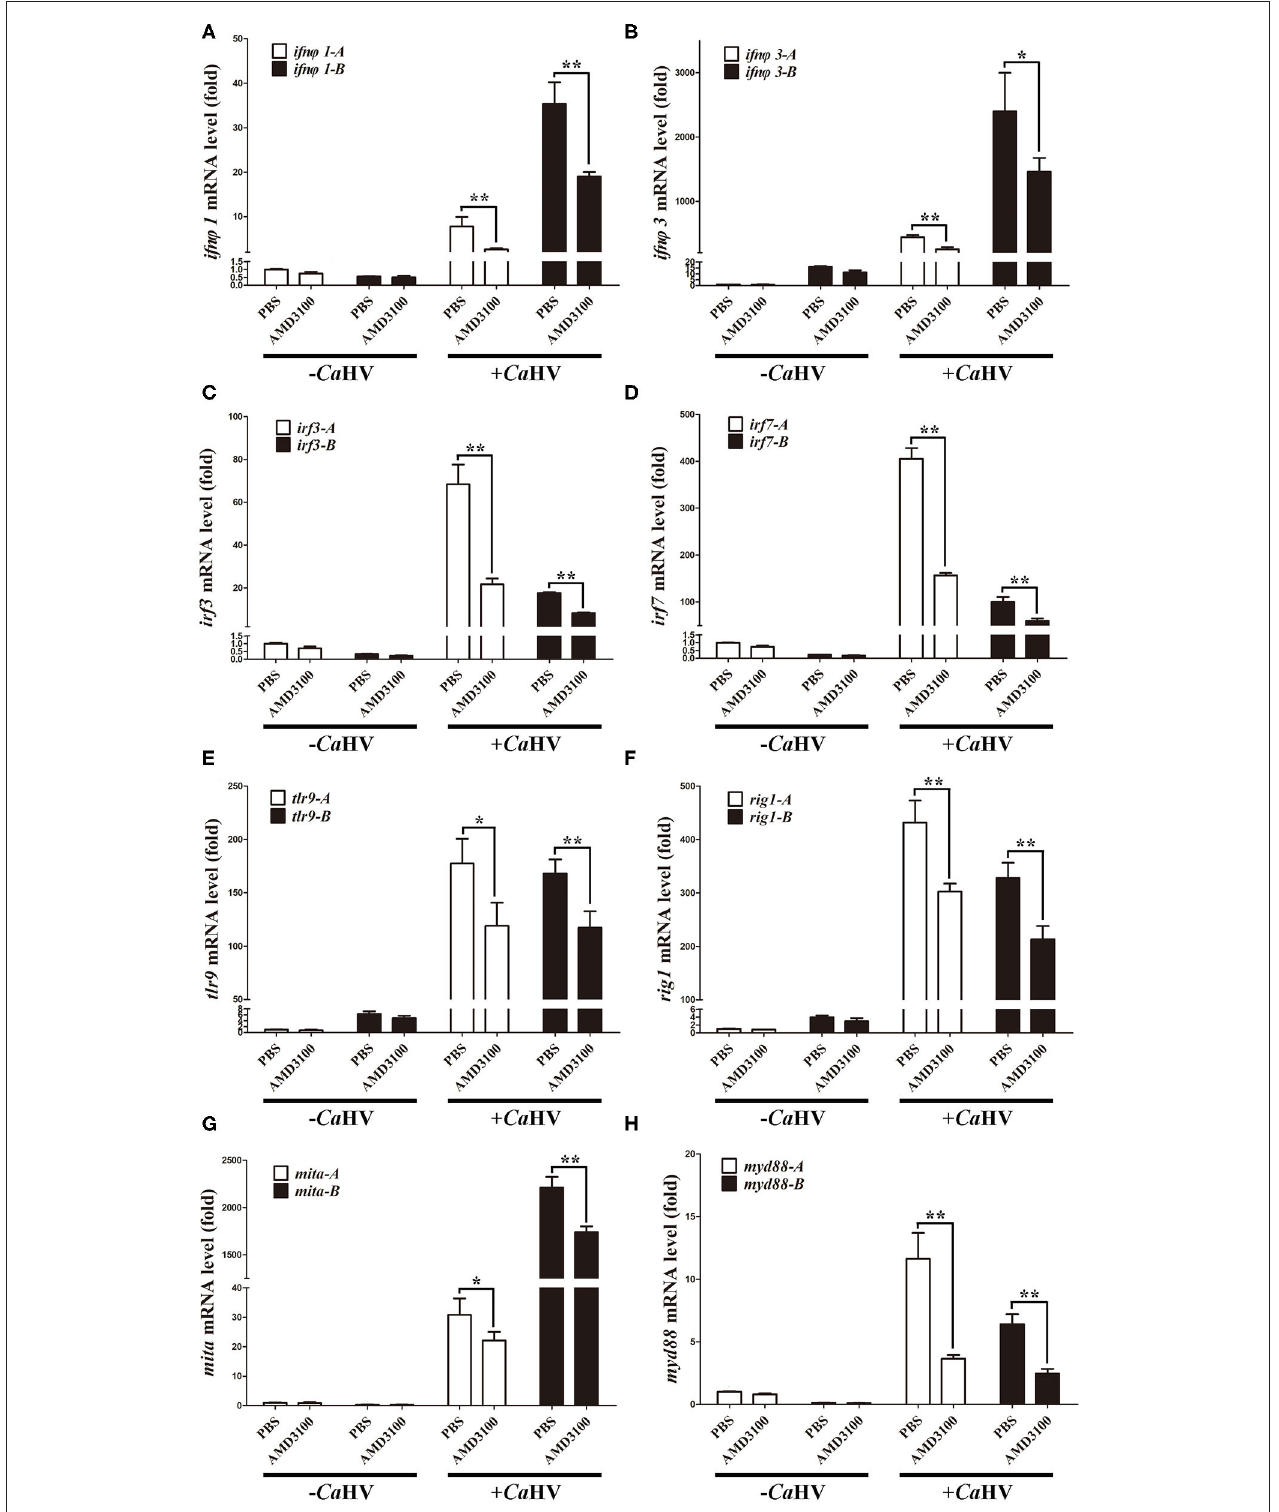
FIGURE 5 | AMD3100 suppressed Ca HV-induced activation of key antiviral genes in gibel carp head kidney. (A–H) qPCR analysis of ifn ϕ 1 (A) , ifn ϕ 3 (B) , irf3 (C) , irf7 (D) , tlr9 (E) , rig1 (F) , mita (G) , and myd88 (H) in AMD3100 treated gibel carp after Ca HV infextion. eef1a1l1 was used as control. Each bar represents mean ± SEM ( n = 3). The asterisks indicate the significant differences (* p < 0.05, ** p < 0.01).